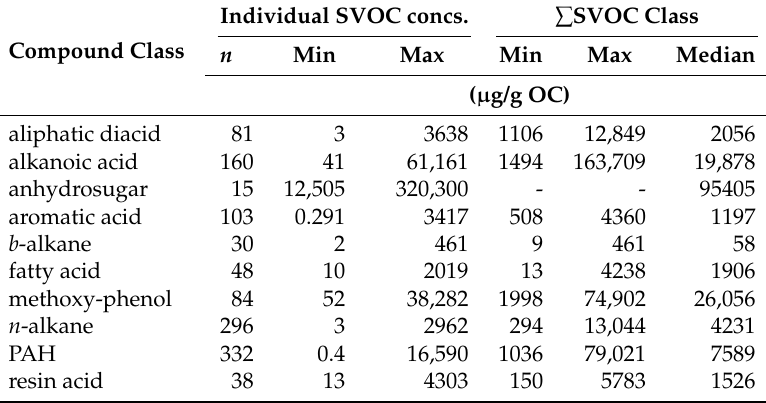
Table 2. The range of individual semivolatile organic compound (SVOC) concentration observations and test-based sum of SVOC concentrations ( N = 15) by compound class. Note that the anhydrosugar class contains levoglucosan